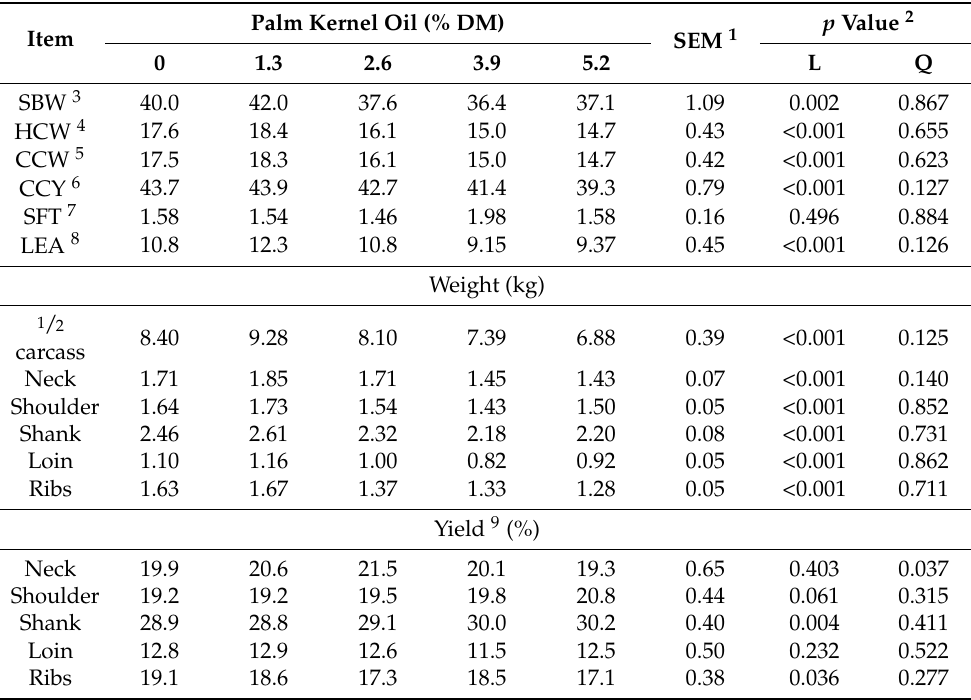
Table 2. Carcass characteristics, weight, and yield of commercial cuts of the carcass of lambs fed diets with different levels of palm kernel oil.